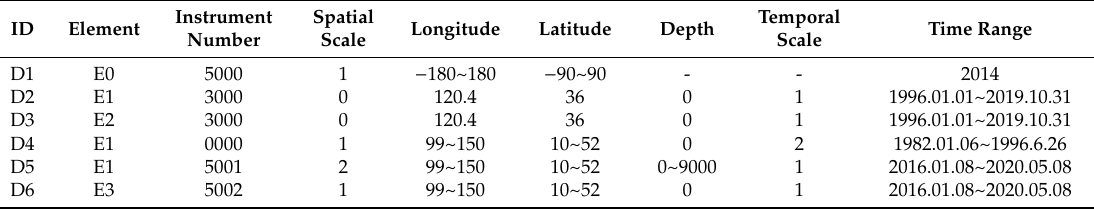
Table 2. Samples of